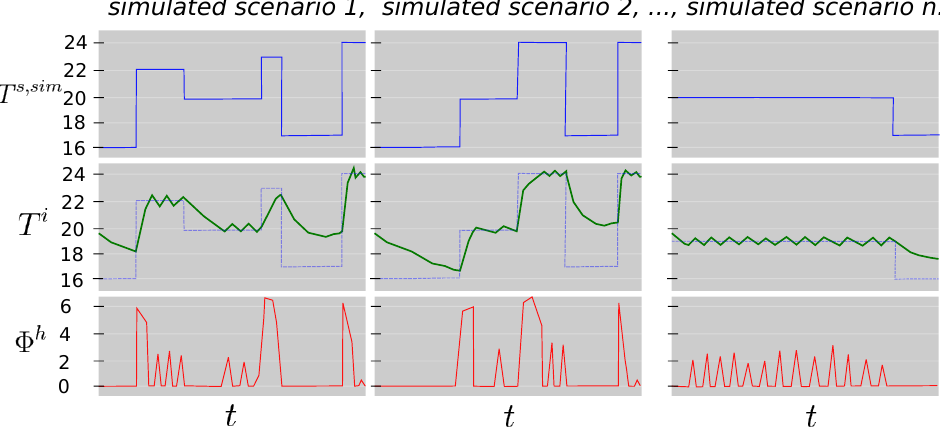
Figure 2. Theoretical examples of 3 different set point temperatures scenarios over the same time period and their related indoor temperature and space heating